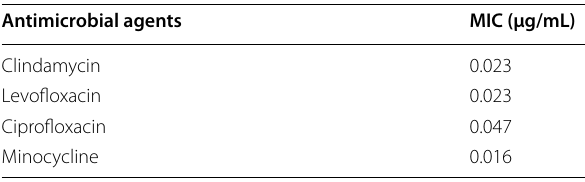
MIC, minimal inhibitory concentration